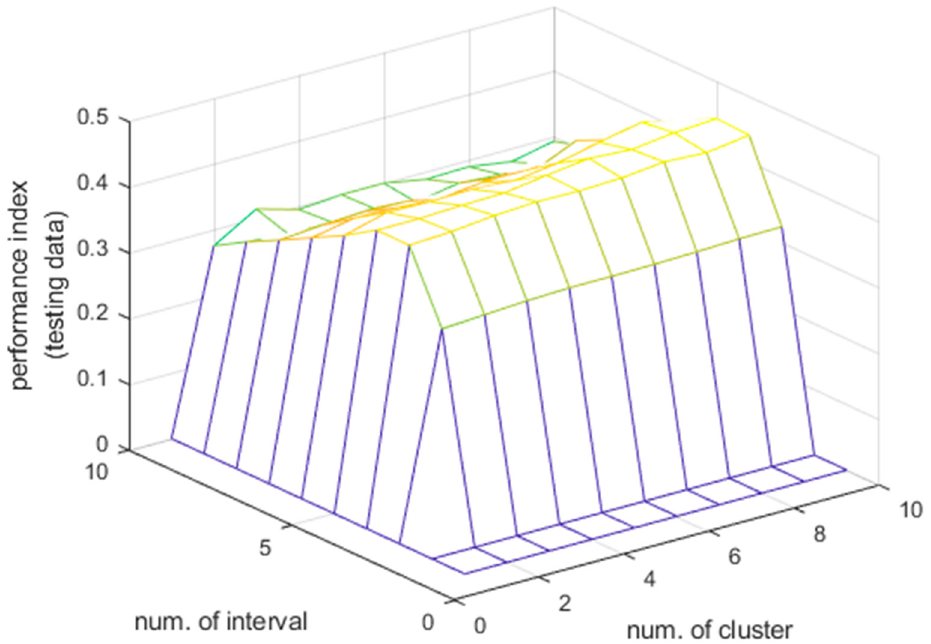
Figure 15. Results of PI method for interval-based IGM (Case 3).